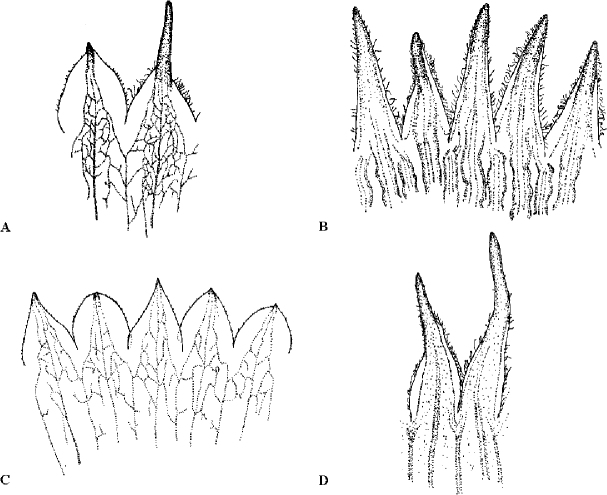
Different types of calyx teeth. ASilene
linearis (M. Bierkamp & P. Zinth 177 BSB) BSilene
austroiranica (Rechinger 10772 B) CSilene
corinthiaca (B. Oxelman 1934 GB) DSilene
georgievskyi (Rechinger 9828 B). A, B and D are representatives of S.
section
Arenosae. Illustrations by F. Eggens.